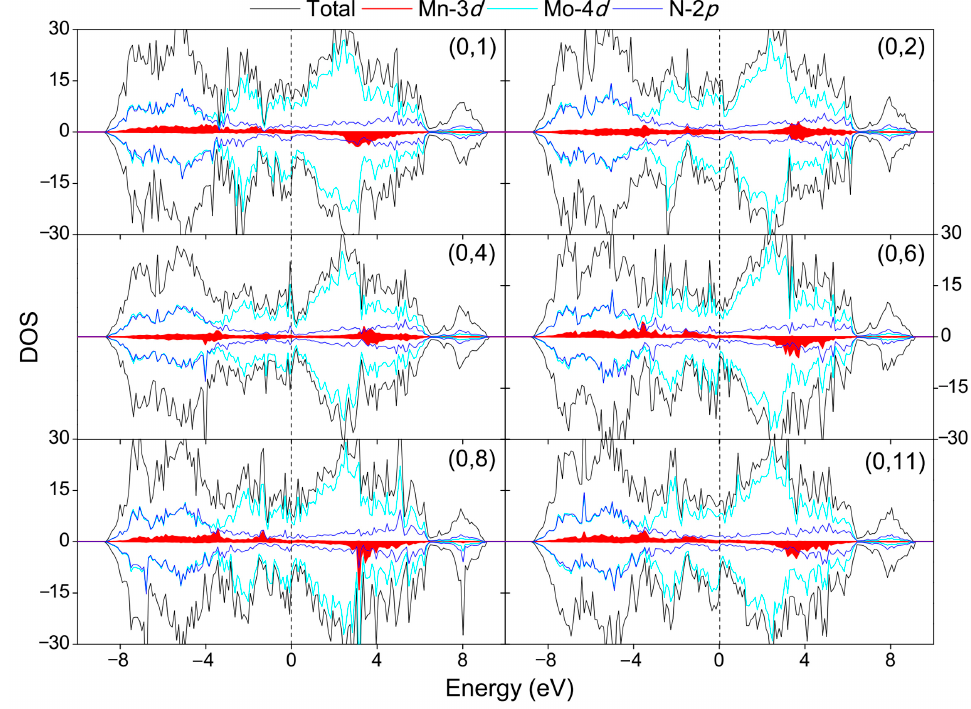
Figure 6. Total and partial DOS of the selected double-doped systems. The Fermi level is set as zero.